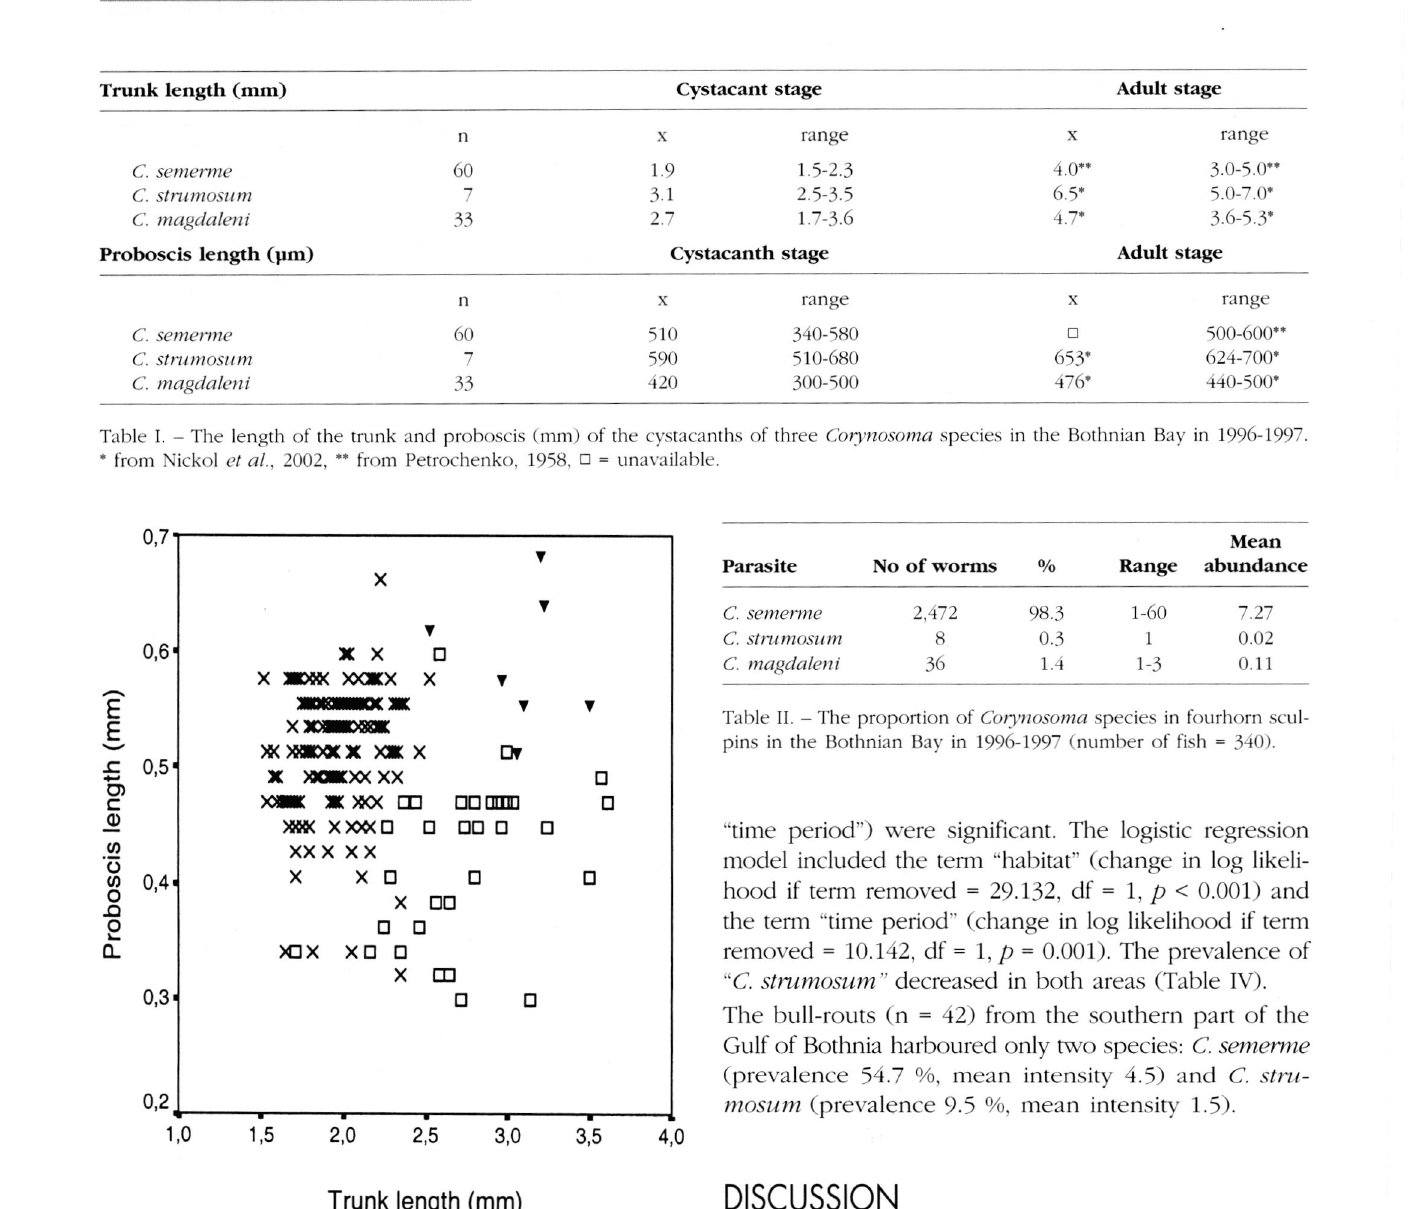
Fig. 2. — The length of the proboscis and trunk (mm) of the three Cory nosoma species in fourhorn sculpins (M. quadricornis) in the Both­ nian Bay in 1996-1997. Each symbol represents a single parasite spe­ cimen, x = C, semerme.